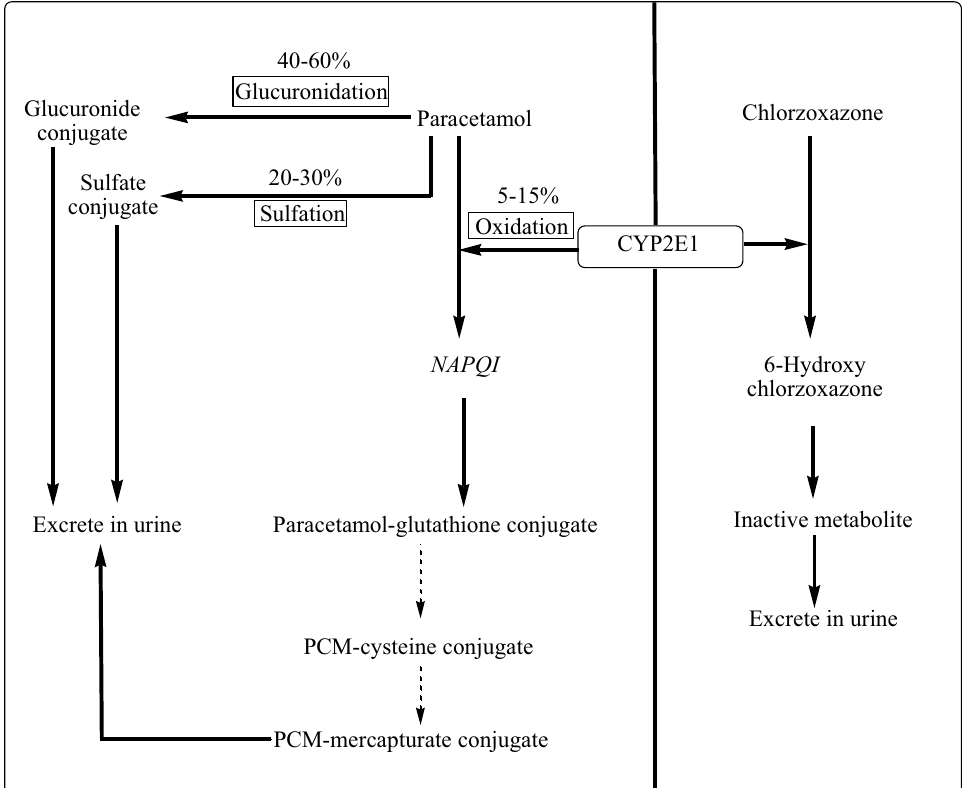
Fig. 1 Metabolism of paracetamol and chlorzoxazone by CYP2E1. NAPQI, N-acetyl- p -benzoquinoneimine; CYP2E1, Cytochrome